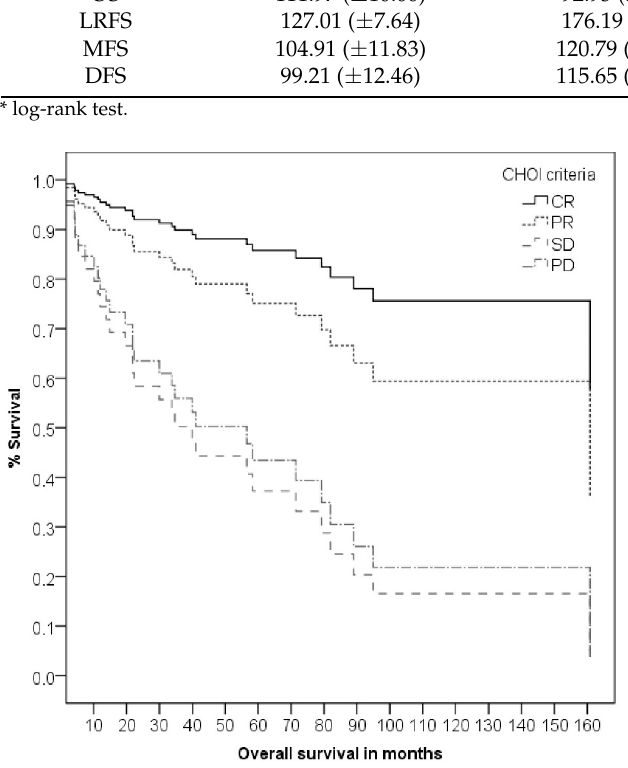
Figure 4. Kaplan–Meier curve of overall survival according to the CHOI-criteria.